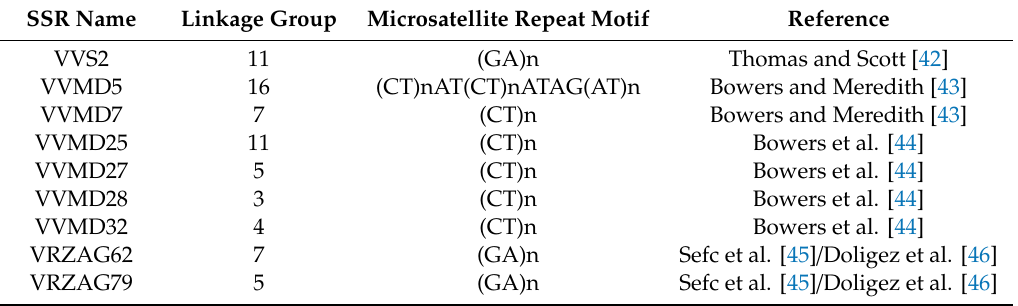
Table 3. Name, linkage group, microsatellite sequences and references of the simple sequence repeats (SSRs) markers used in this